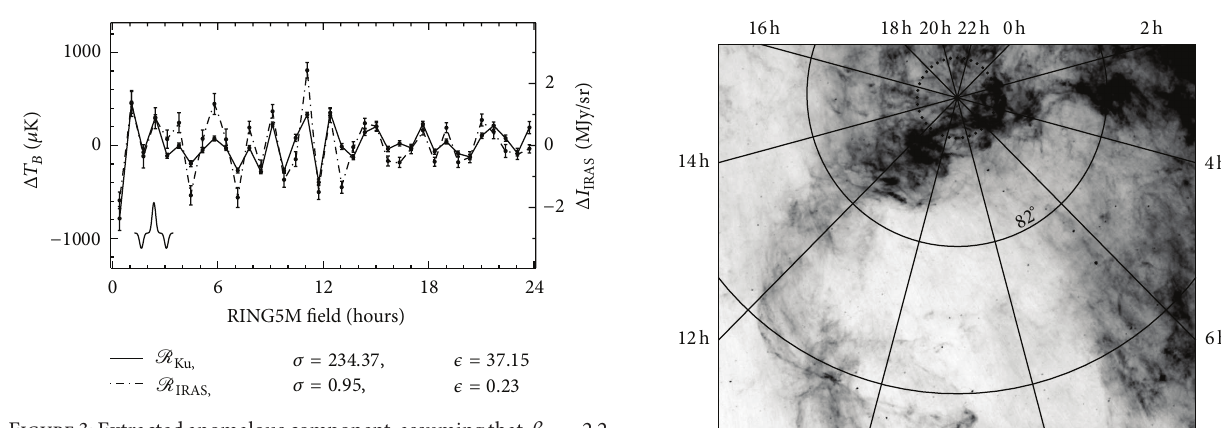
Figure3:Extractedanomalouscomponent,assumingthat 𝛽 = −2.2 (solid line) is overplotted with amplitudes from the IRAS 100 𝜇 m map (dashed line). Both represent sky amplitudes, convolved with the double-switched beam pattern of the RING5M observations, indicated at the bottom left of the figure.